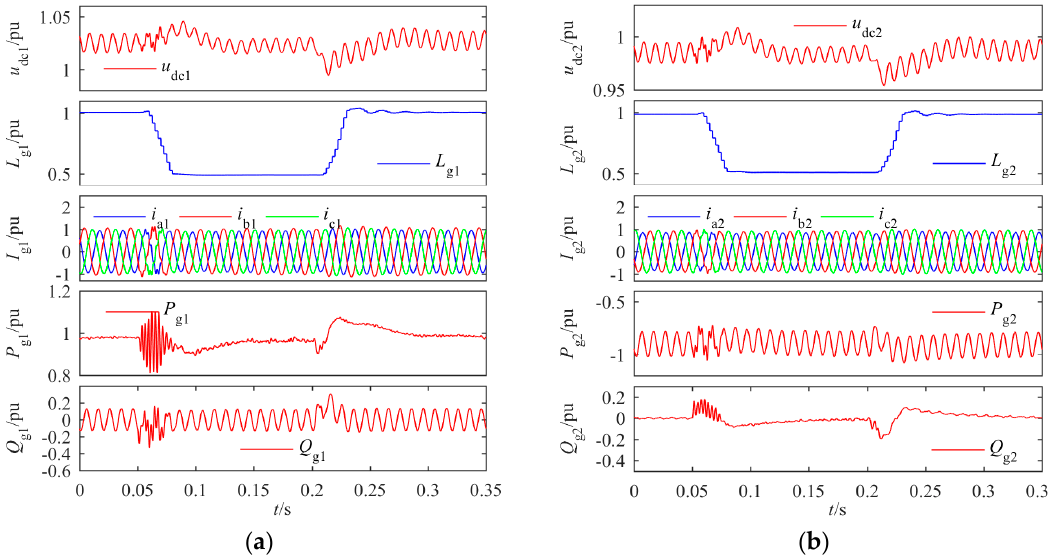
Figure 14. Responses of CS1 ( a ) and CS2 ( b ) to inductance parameter step changes under UBGV conditions.